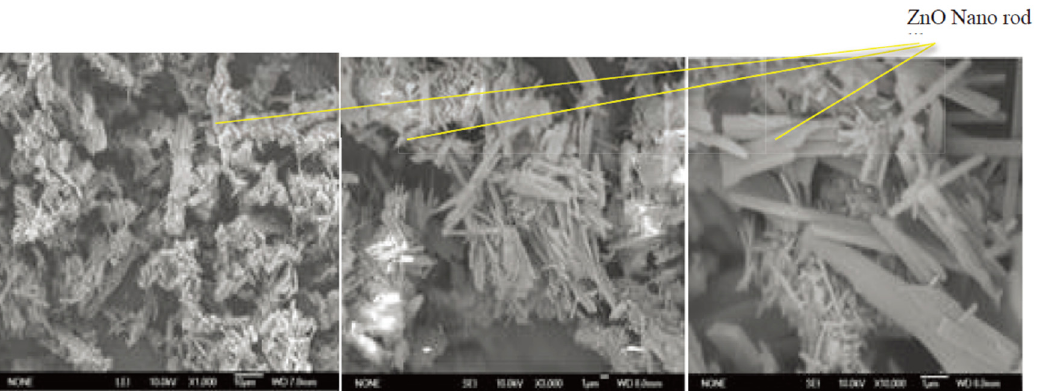
Figure 1. FE-SEM micrographs of synthesized ZnO at different magnifications. Reprinted/adapted with permission from Ref. [45]. Copyright © 2022, Elsevier B.V.